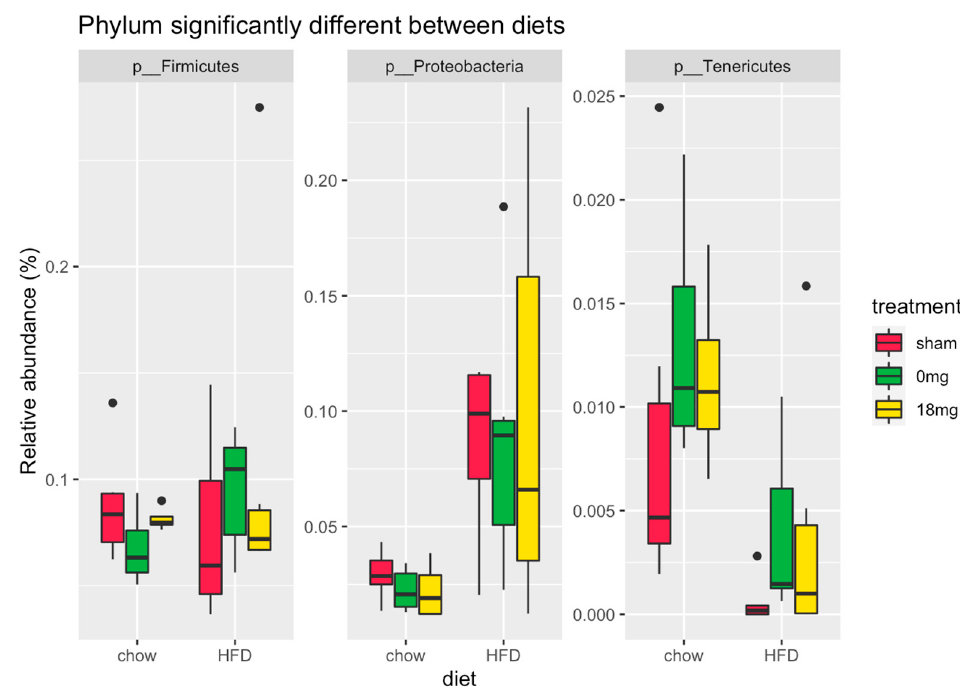
Figure 3. Abundance by diet. HFD: high-fat diet; sham: exposed to ambient air; 18 mg: exposed to nicotine-containing e-vapour; 0 mg: exposed to nicotine-free e-vapour.